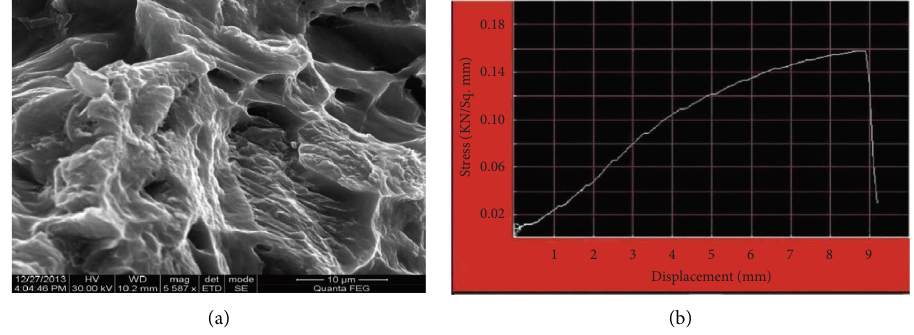
2 O 3 + 5wt.% of Gr [76].